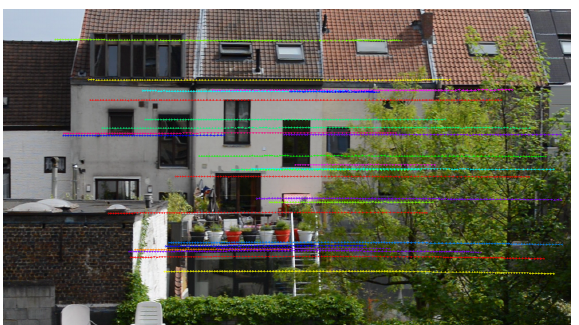
Figure 3. Example of feature-point tracking using SURF [31] in a panning video. The tracks of distinct feature points are visualized in different colors. Please note that tracks represent the apparent trajectory in the image, and not their motion throughout the